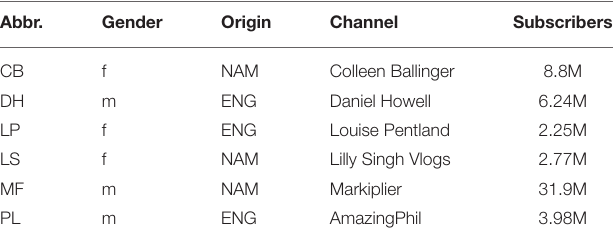
TABLE 1 | Overview of YouTubers in sample, including identifying abbreviations, gender (f, female; m, male), origin (NAM, North America; ENG, England), channel with the analyzed video, and subscriber count of that channel (in million, obtained February 8, 2022).